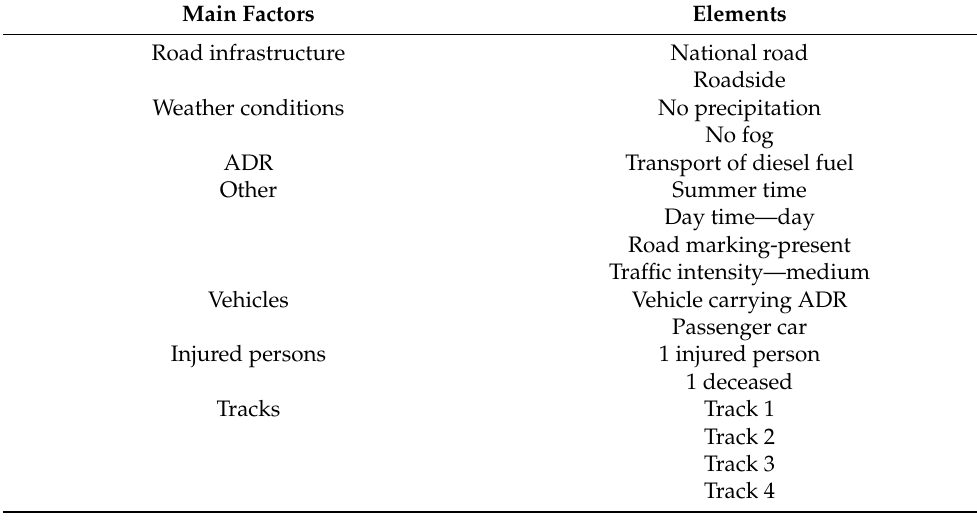
Table 6. Scenario 2.